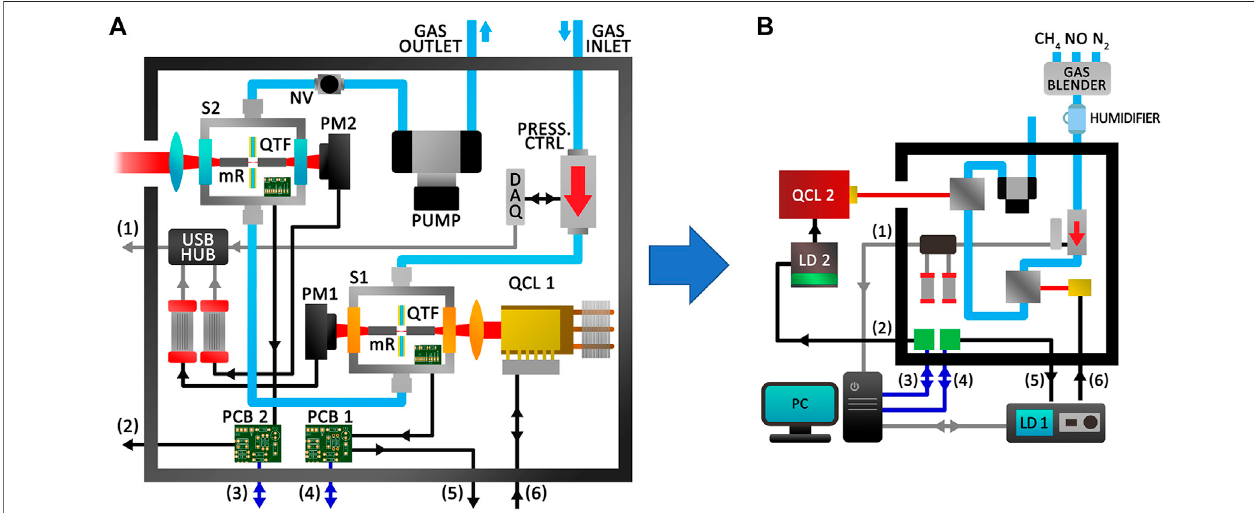
FIGURE 1 | (A) Schematic of the developed sensor architecture. Blue arrows represent the cables of the NI PCIe-6363 DAQ, installed in the computer and employed to both generate and acquire signals. USB cables are represented with grey arrows. Black arrows represent cables employed for the distribution of analog signals, both inside and outside the sensor. (B) Schematic of the setup realized for simultaneous detection of methane and nitric oxide. S1-Sensor 1; S2-Sensor two; QTF-Quartz Tuning Fork; mR -Resonator tubes; PM1- Power Meter 1; PM2- Power Meter two; PCB 1-Printed Circuit Board 1; PCB 2-Printed Circuit Board two; QCL 1-Quantum Cascade Laser 1; QCL 2-Quantum Cascade Laser two; DAQ-Data acquisition board; Press. Ctrl-Pressure controller; NV-Needle Valve; LD 1- Laser Driver 1; LD 2-Laser Driver two; PC-Personal Computer. 7 – 12 µm and 3 – 5 µm AR coated optical elements in S1 and S2 are represented in orange and blue,